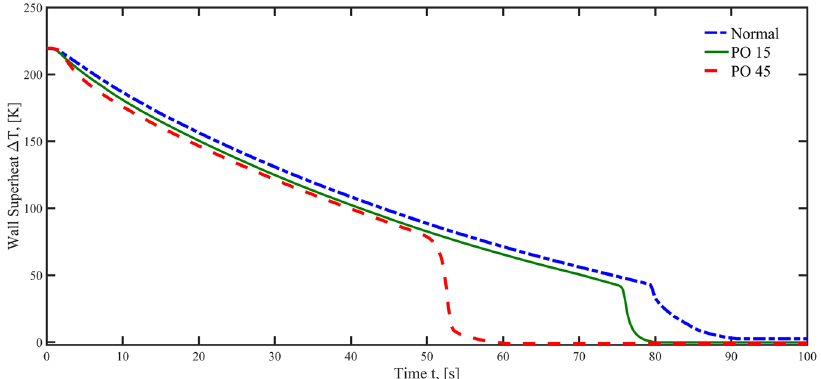
Figure 4. Quenching curves for the three experimental